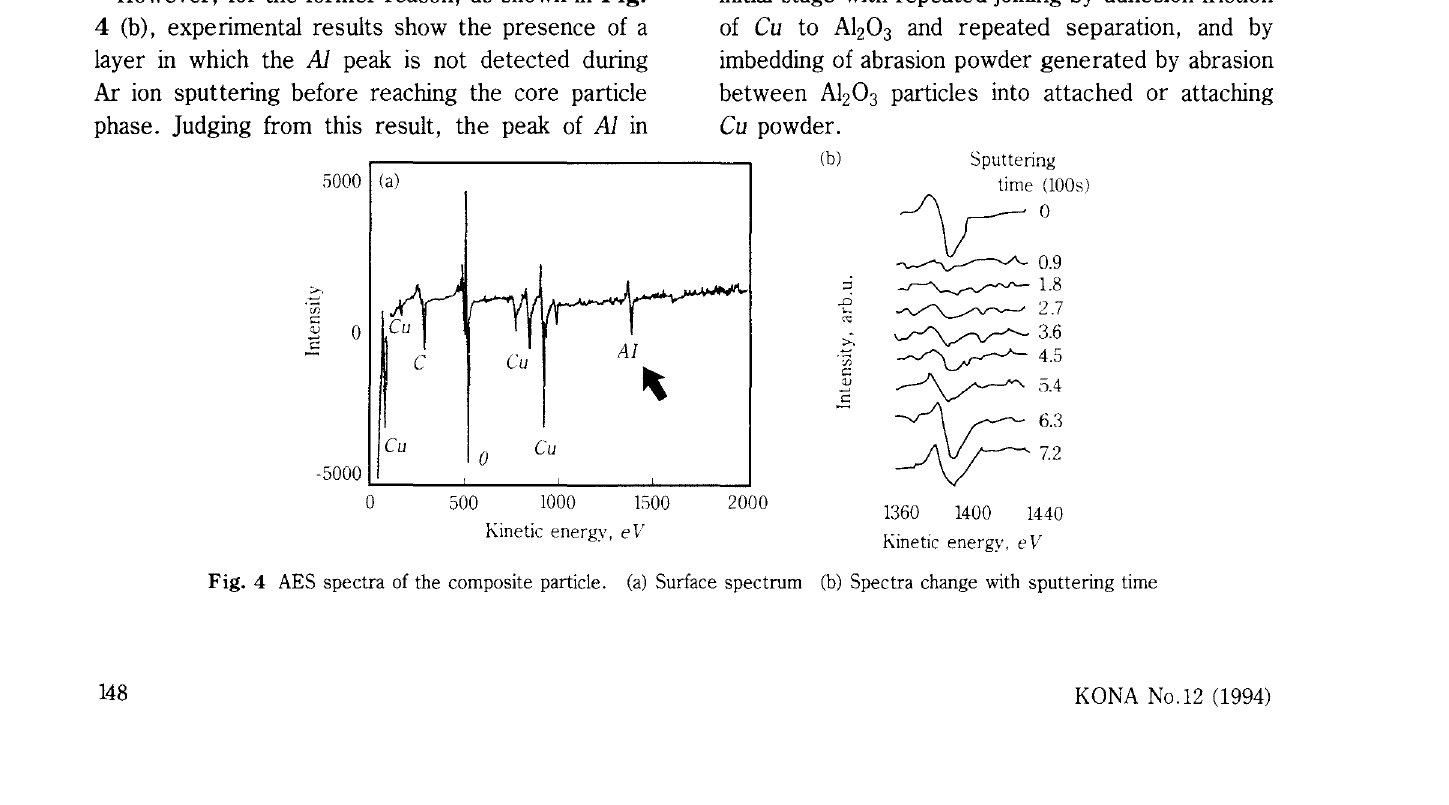
Fig. 4 AES spectra of the composite particle. (a) Surface spectrum (b) Spectra change with sputtering